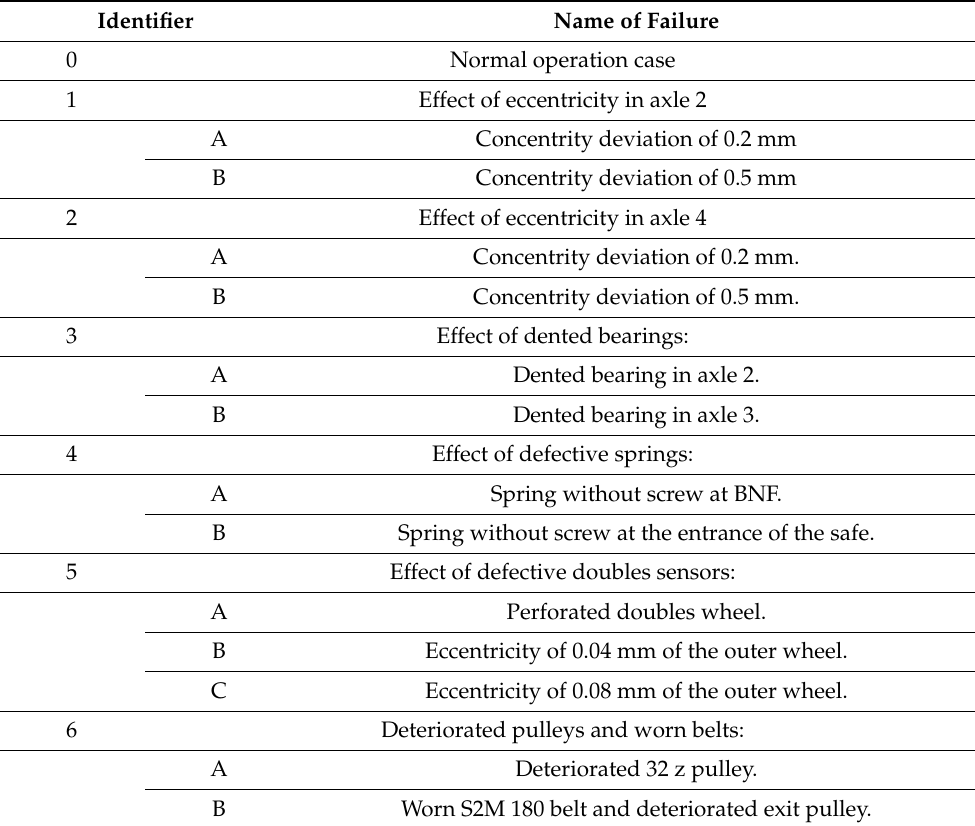
Table 2. Summary of the tested